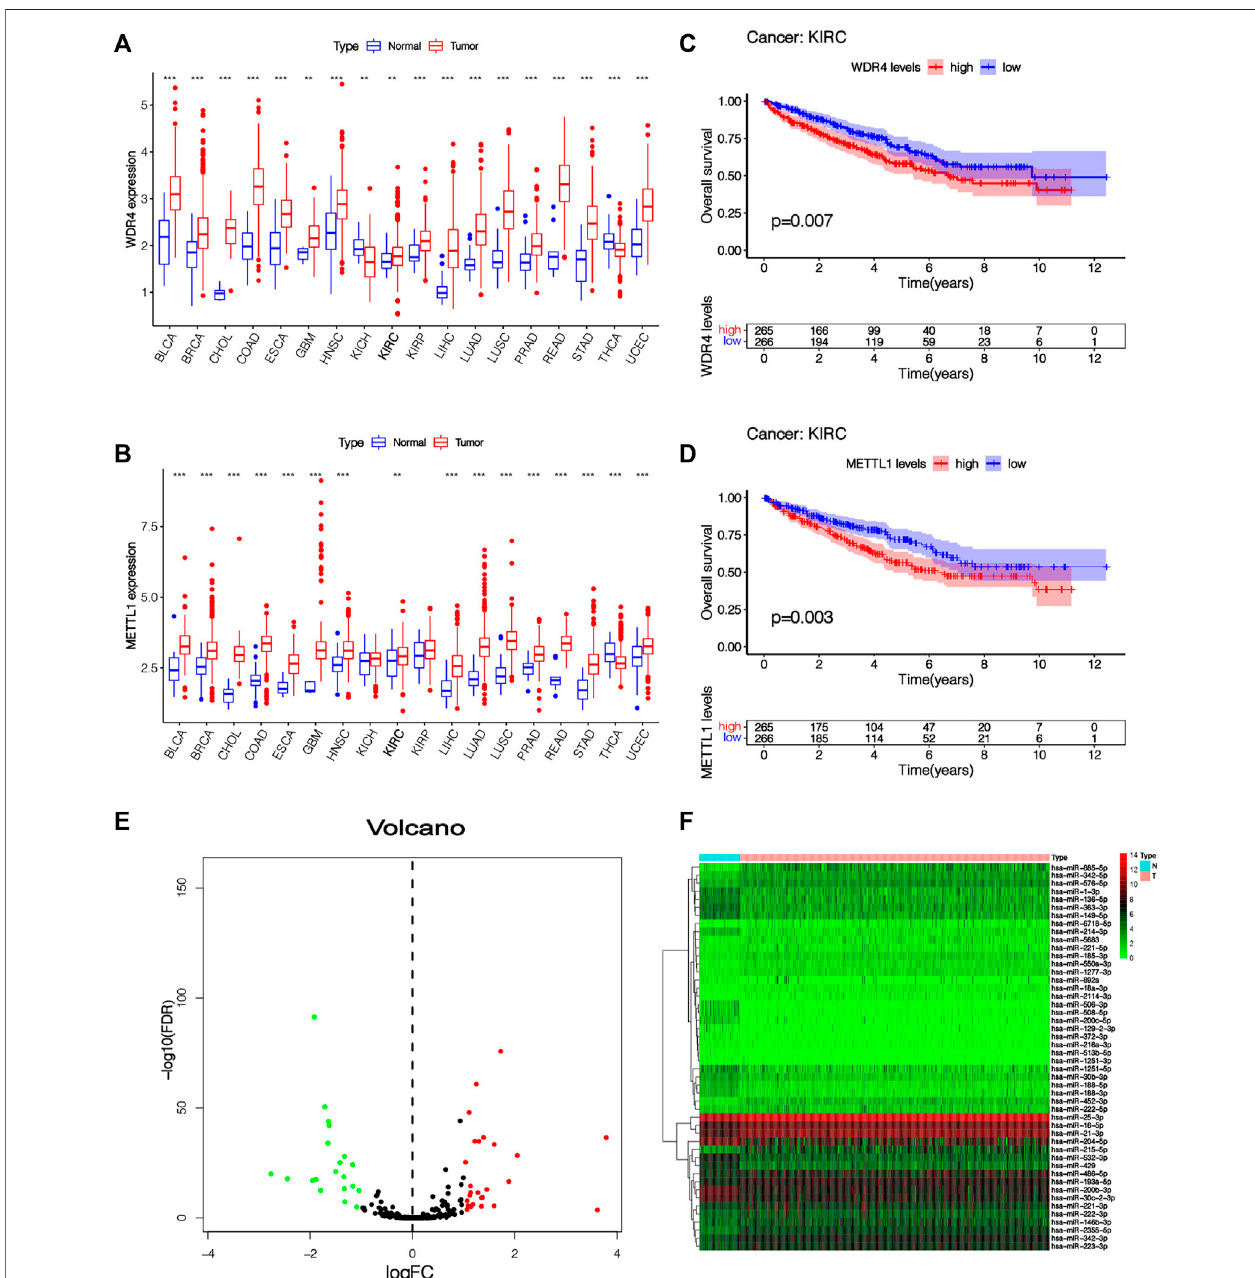
FIGURE2| The expression levelofm7G-related genesand m7G-related miRNAs. (A,B) Pan-cancer analysisofMETTL1 andWDR4in18tumor types. (C,D) K-M survival curve analysis of METTL1 and WDR4 in KIRC patients. (E) The volcanic plot of differentially expressed m7G-related miRNAs between KIRC tissue and normal tissue,whichindicatesthatthedistributionoflog2FCand p valuesisreasonable. (F) Heatmapof48differentiallyexpressedmiRNAsexpressedinKIRCtissueandnormal tissue.